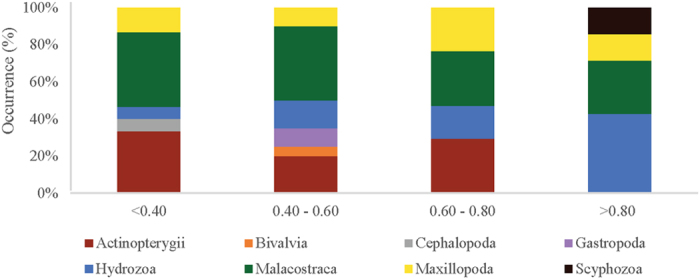
Barplot showing the occurrence of each taxonomic group consumed per sunfish size class (in metres).